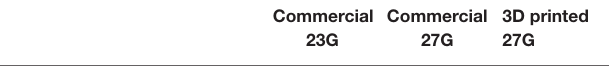
TABLE 2 | Maximum forces measured during insertion of commercial and 3D printed trocars into an artificial eye